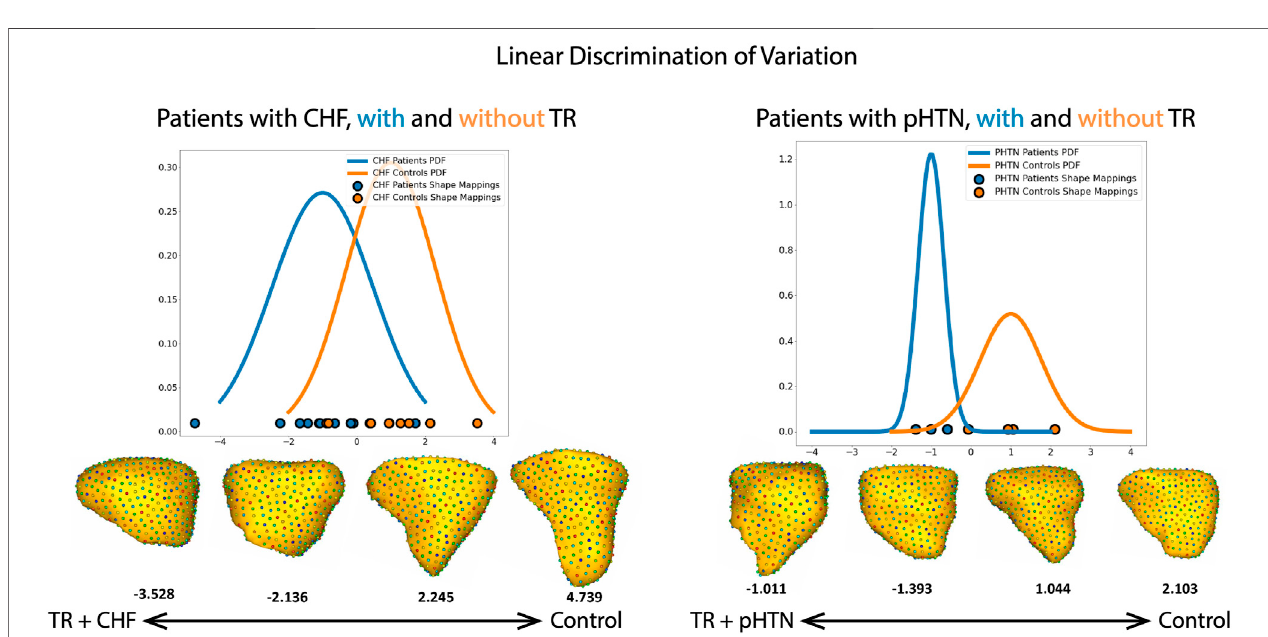
FIGURE 8 | Shape mapping to linear discrimination of variation between population means, for the subgroups of patients with CHF and pulmonary hypertension (pHTN). The group mean for patients with TR is set as − 1, and for patients without TR is set as 1. PDF = probability density function. Selected RV shapes correspond to individual points on the graph, and are shown as seen from the free wall. The number below each shape denote the single scalar value (or a “ shape-based-score ” ) that places a subject-speci fi c anatomy on a group-based shape difference that is statistically derived from the shape population.